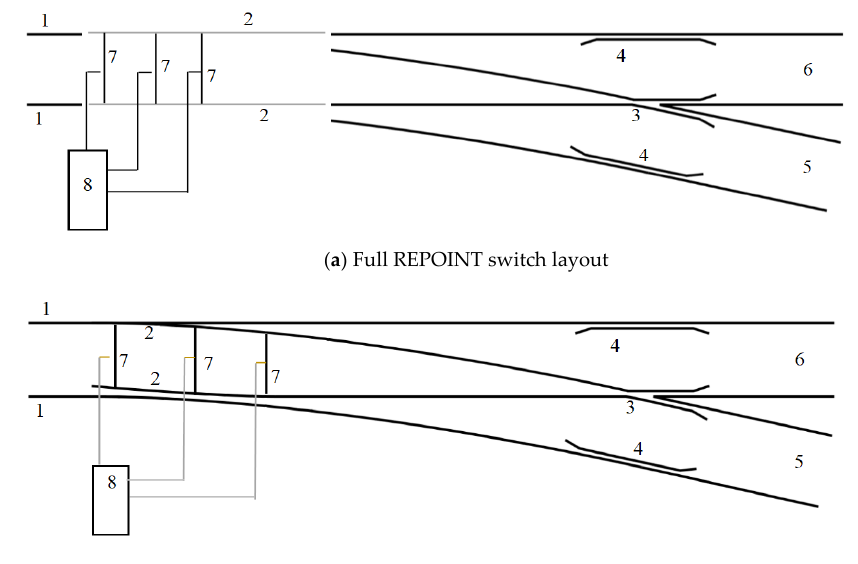
Figure 1. Different layout for full REPOINT and REPOINT-Light systems ( a , b ). Numbered elements: 1. Stock rails, 2. Movable switch rails, 3. Common crossing, 4. Check rails, 5. Divergent route, 6. Straight route, 7. Actuators with in-built lock and detection system, 8. POE (Point Operating Unit).